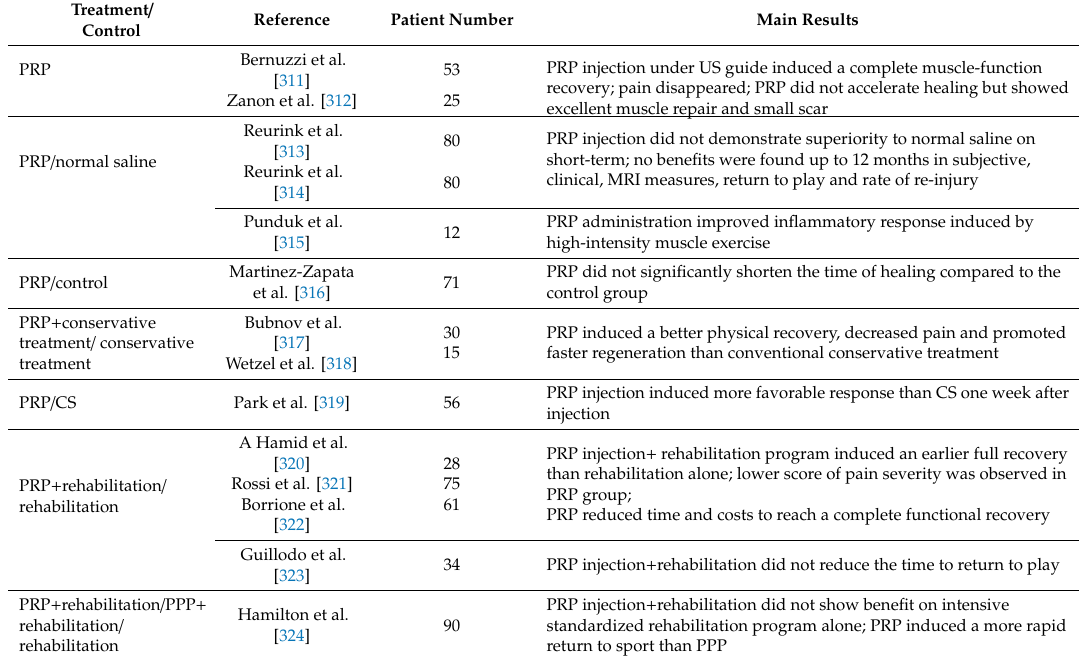
Table 9. Evidence of PRP treatment in muscle injuries (reported by year of study and treatment type). Treatment /